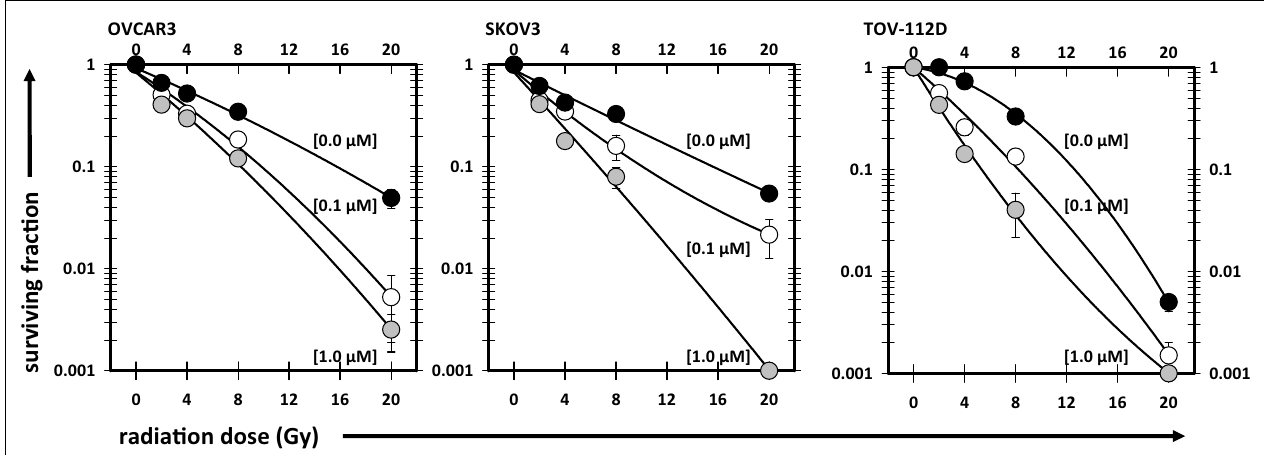
6h; drug-free medium was exchanged afterward for the duration of the assay. Mean and standard errors are presented. Fitted linear-quadratic regressions are plotted.